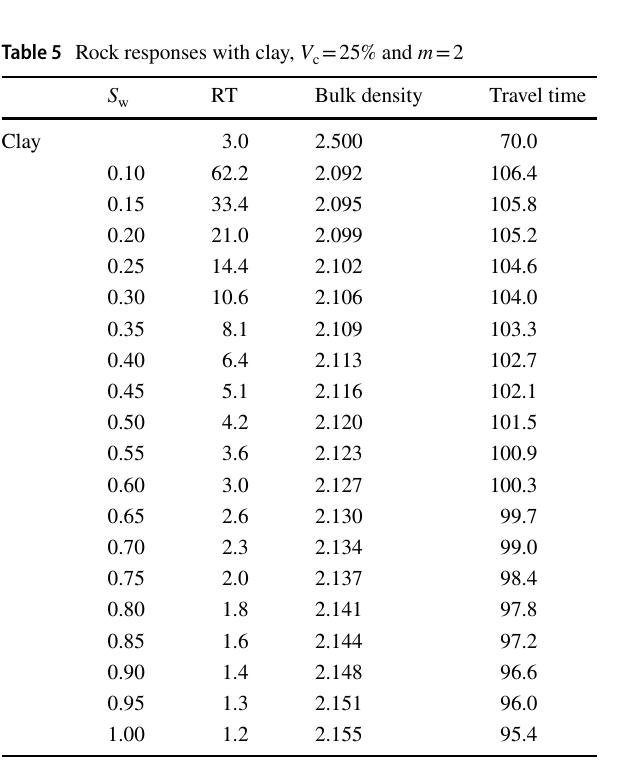
Fig. 9 Sonic–resistivity overlay, clay = 50%